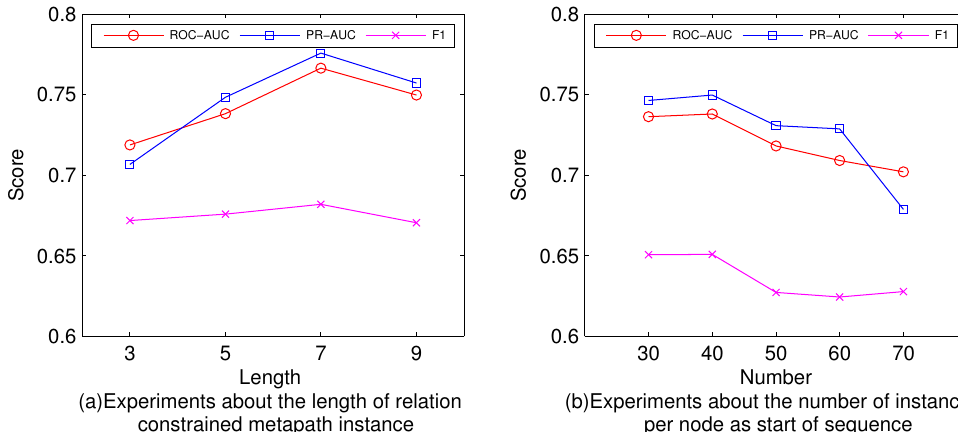
Figure 6. Parameters experiments of the Twitter